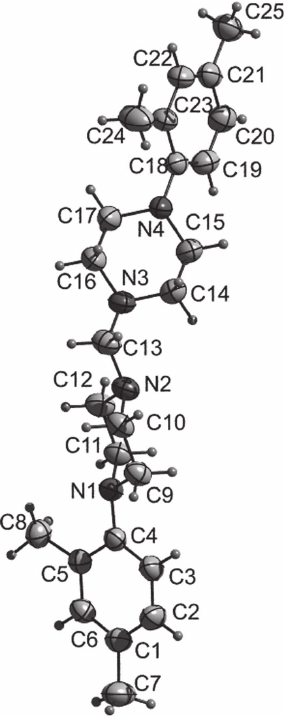
Table 1: Data collection and handling.